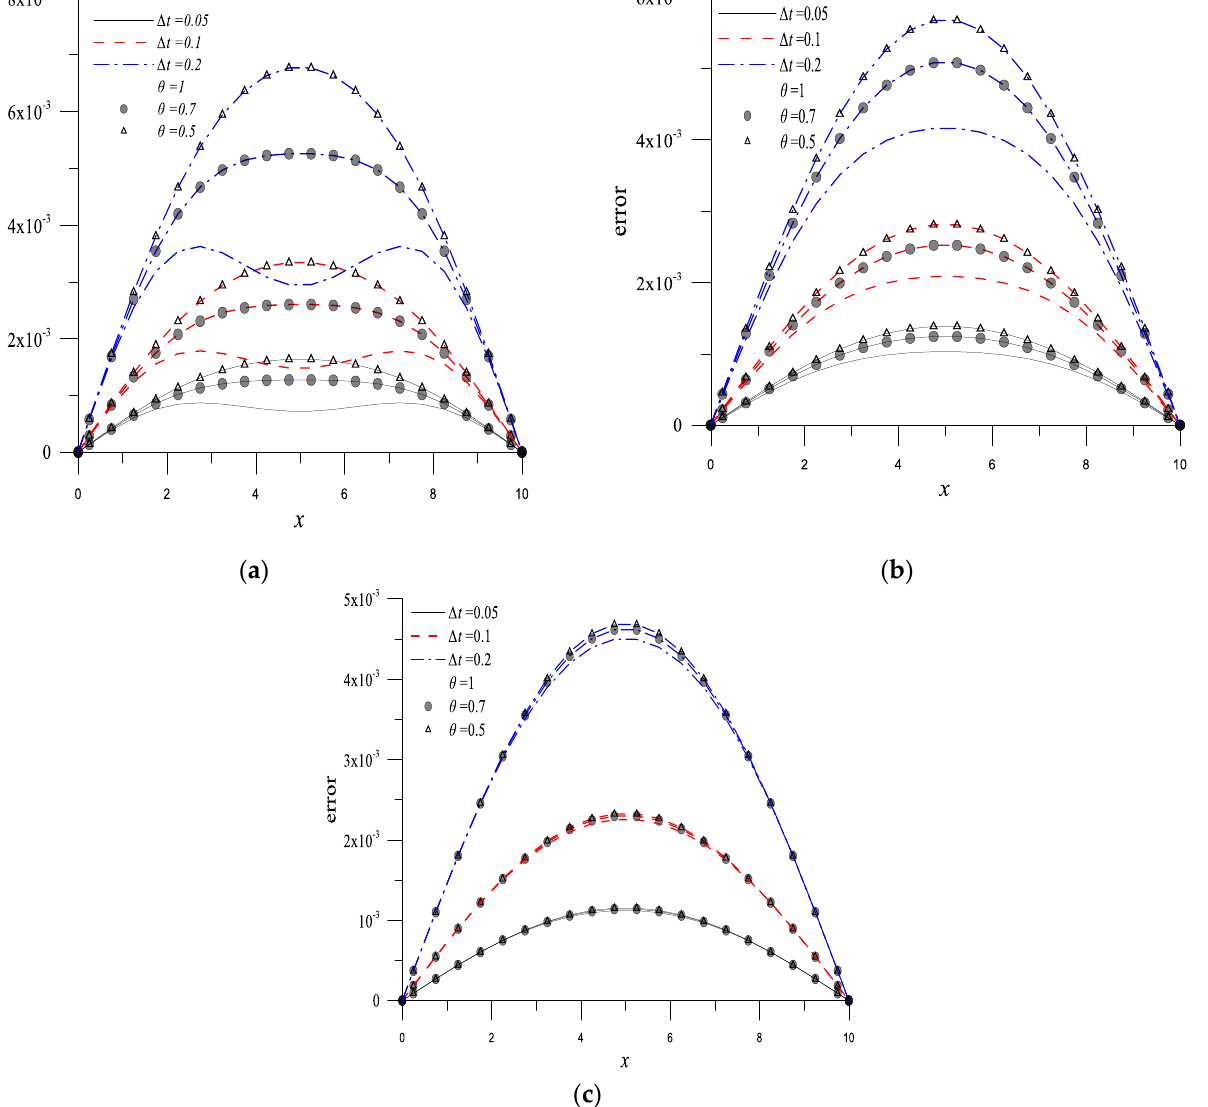
Figure 7. Errors obtained by the Hermite MAPS with different ∆ t and θ at ( a ) t = 6, ( b ) t = 8, and ( c ) t = 10 for Example